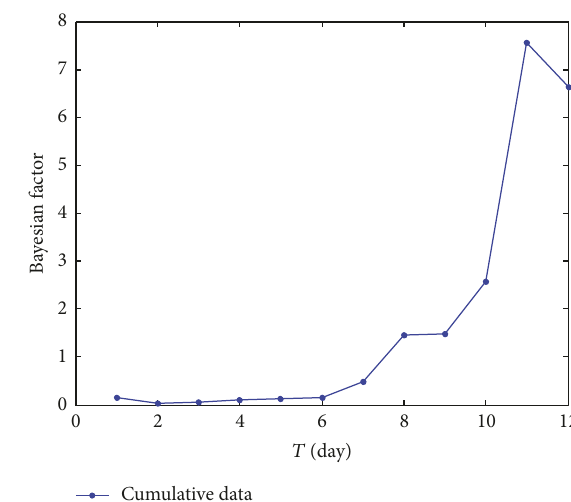
Figure 8: Monitored and predicted extreme stress data.